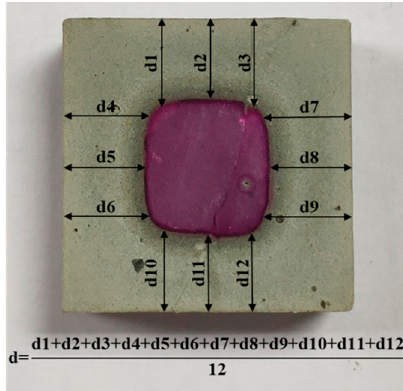
Figure 2. Leaching depth test for the sample exposed to 6 mol/L NH 4 Cl solution.